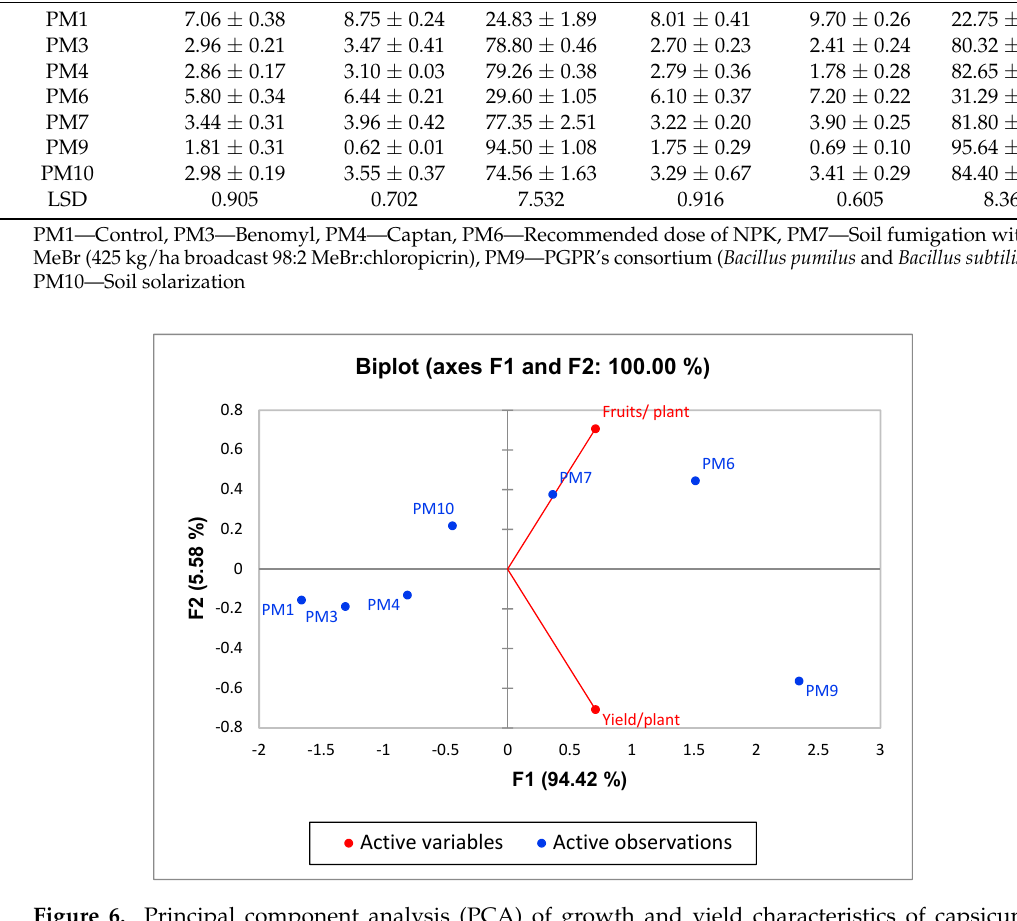
Figure 6. Principal component analysis (PCA) of growth and yield characteristics of